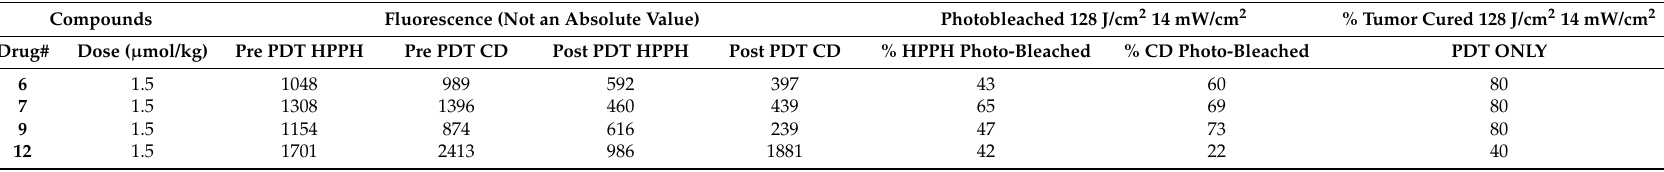
Table 1. Summary of a comparative in vivo photobleaching of HPPH moiety in HPPH-CD conjugates 6 , 7 , 9 and 12 after the light treatment (128 J/cm 2 and 14 mW/cm 2 ) for 30 min. The tumors were exposed to light at 665 nm (in vivo absorption of HPPH at its longest wavelength absorption) after 24 h post-injection of the conjugates.